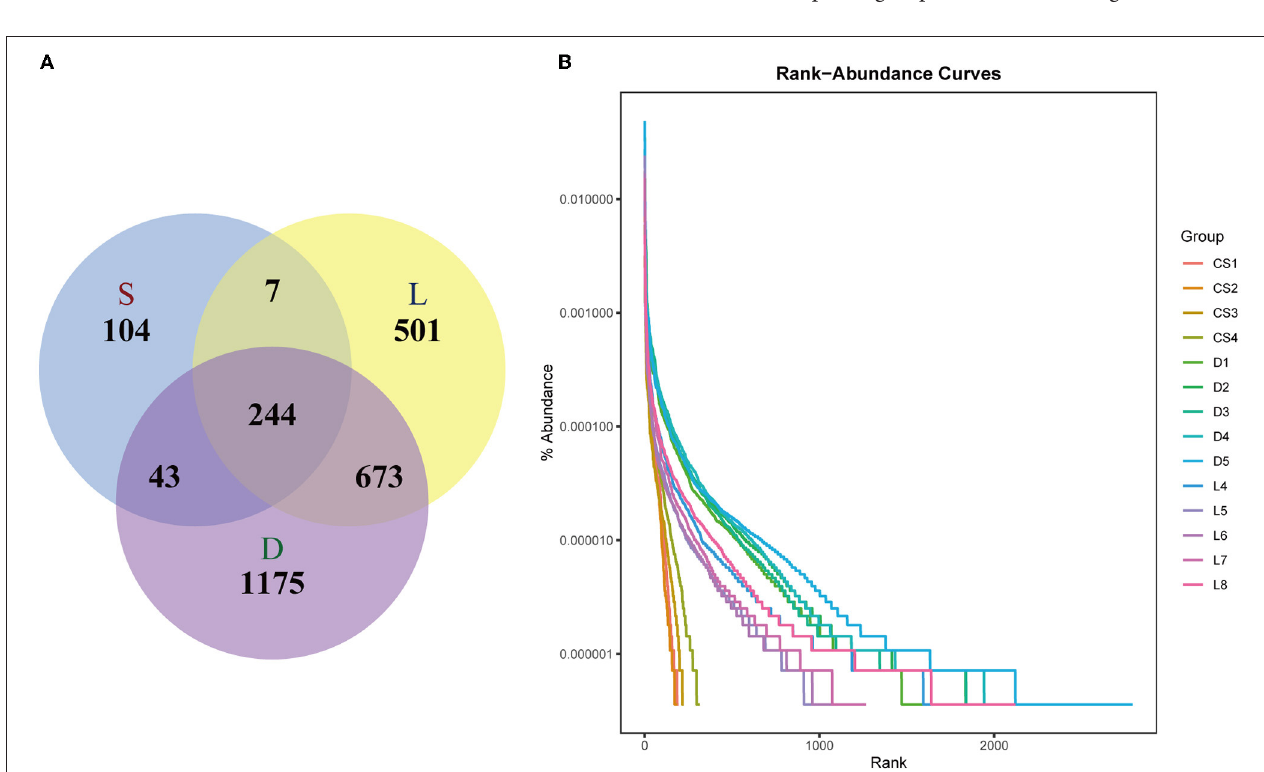
FIGURE 2 | Venn diagram (A) and the rank–abundance curves (B) . There were 244 shared OTUs among the three groups, wherein the OTUs number of German Shepherd group (2,135) was the highest, and then the OTUs number of Labrador retriever group (1,425) was much higher than that of the Springer Spaniel group (398). The vertical axis of the rank–abundance curves showed the percent of OTUs after sampling, while the horizontal axis showed the number of sequences, and the tail length of rank–abundance curves revealed the bacterial community richness.